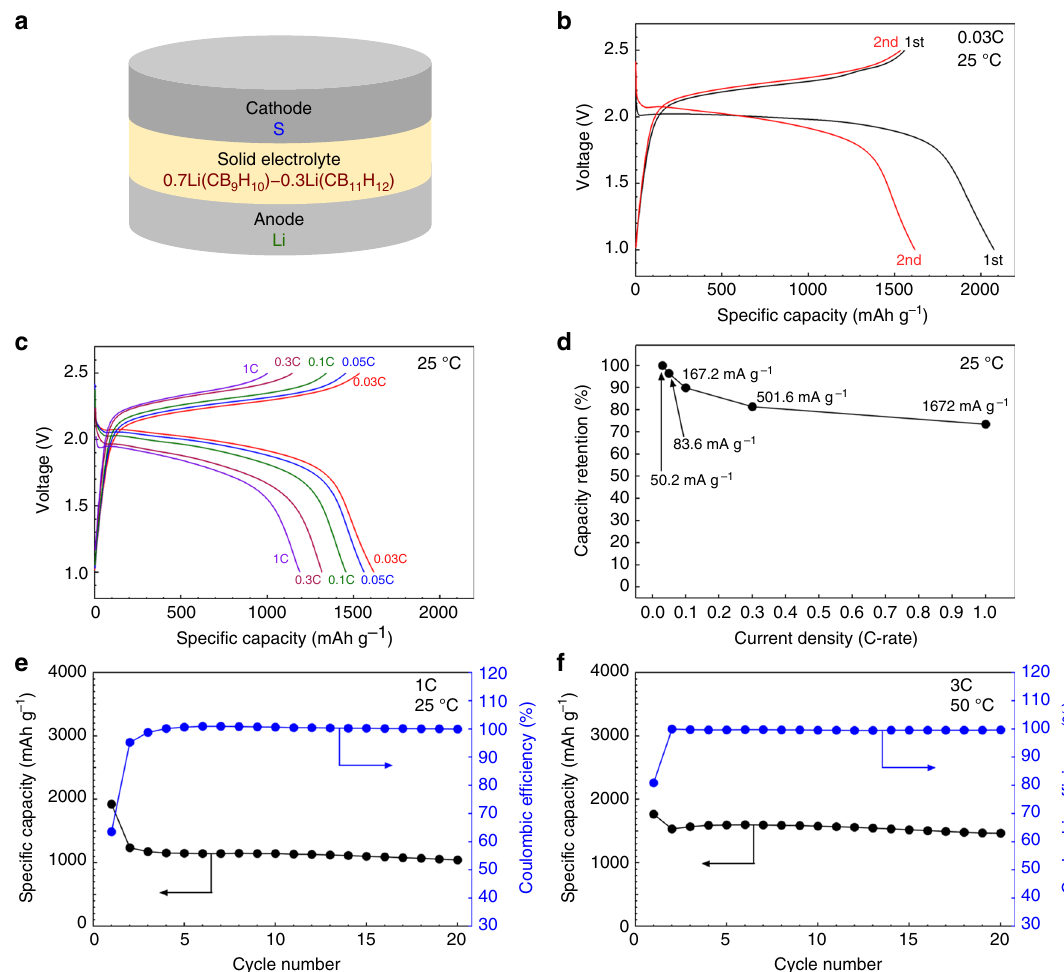
Fig. 5 High-energy-density all-solid-state lithium metal batteries. a Schematic illustration of the prepared all-solid-state batteries. S, Li/0.7Li(CB 9 H 10 ) – 0.3Li (CB 11 H 12 ), and lithium metal were used as the cathodes, solid electrolytes, and anodes, respectively. b Voltage pro fi les for a rate of 0.03 C (50.2 mA g − 1 ) at 25 °C during the fi rst two cycles. c Discharge – charge pro fi les at 0.03, 0.05, 0.1, 0.3, and 1 C after an initial cycle at 25 °C. d Capacity retention as a function of current density. e , f Cycling performances of discharge capacity and coulombic ef fi ciency ( e ) for a rate of 1 C at 25 °C and ( f ) for a discharging rate of 3 C and a charging rate of 1 C at 50